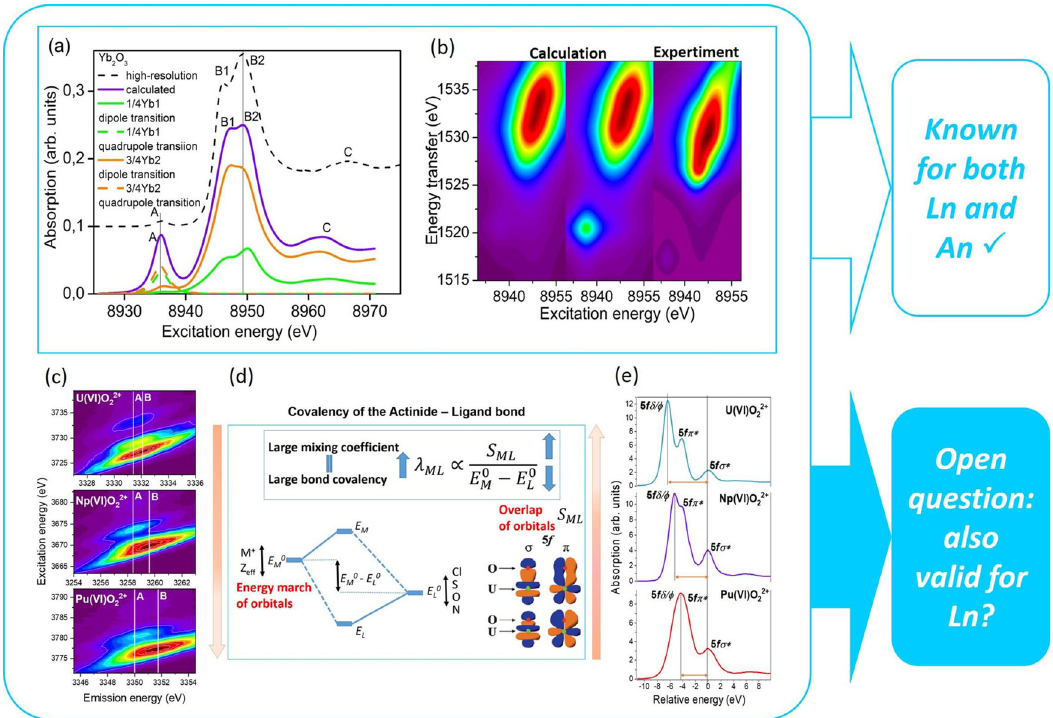
Fig. 1 Spectroscopic methods probing in detail the bonding properties of lanthanide and actinide atoms in corresponding compounds. a Yb L 3 -edge HR- XANES of Yb 2 O 3 and b Yb L 3 3d4f CC-RIXS experiment and calculations of Yb 2 O 3 . c The RIXS maps of UO 2 2 + , NpO 2 2 + , and PuO 2 2 + in aqueous solution. The white lines mark the maximum intensity of the normal emission (line A) and resonant emission (line B). The shift between lines A and B grows from top to bottom (pink arrow) and correlates with the increasing localization of the 5f valence orbitals from U to Pu (E M 0 shifts down) and thus the energy match of orbitals improves. d The dependency of the mixing coef fi cient ( λ ML ) on the energy match E M − E L (energy difference) and the overlap of the metal and ligand valence orbitals S ML , the molecular orbital (MO) scheme depicts how the energy match changes as a function of Z eff /M + oxidation state 1 . The overlap of M and L valence orbitals for two U – O bond distances. e The U M 4 edge HR-XANES spectra of UO 2 2 + , NpO 2 2 + , and PuO 2 2 + . The energy shift between the 5f δ / ϕ and 5f σ * peaks rises from bottom to top (pink arrow) and thus the orbital overlap increases from Pu to U. Panels a and b are adapted from ref. 17 , c and e from ref. 13